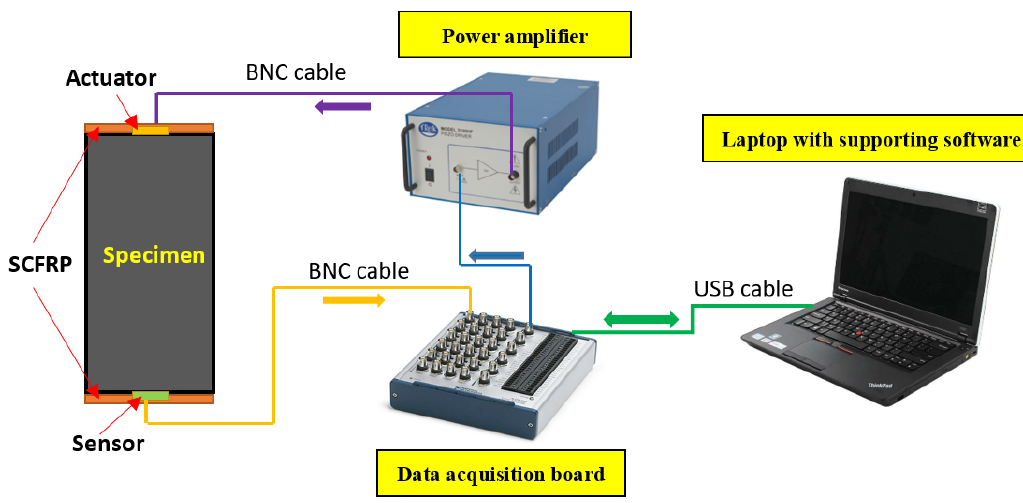
Figure 5. Procedure of the SCFRP system.